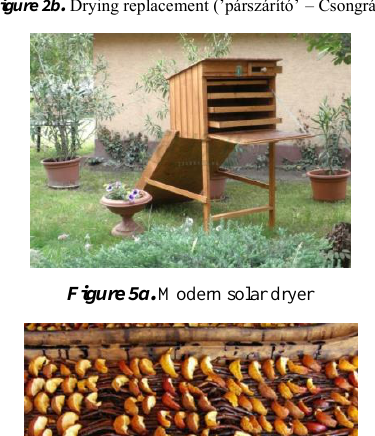
Figure 1. Idea: frozen apples? Figure 2a. Basket dryer (’kópic’ – Kercaszomor) Figure 2b. Drying replacement (’párszárító’ – Csongrád)